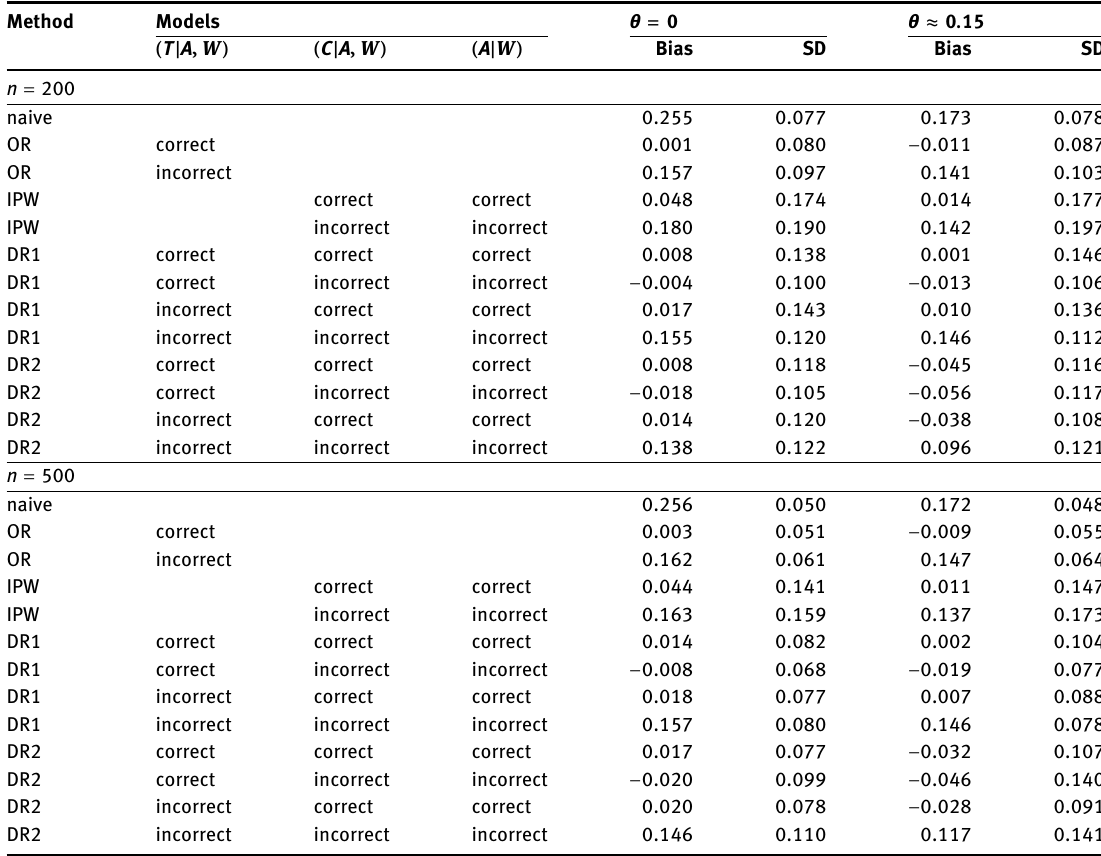
Table 1: Simulation results: empirical bias and standard deviation (SD) for the naive, OR, IPW, DR1 and DR2 estimators with correct and incorrect working models (see Section 3.1 for